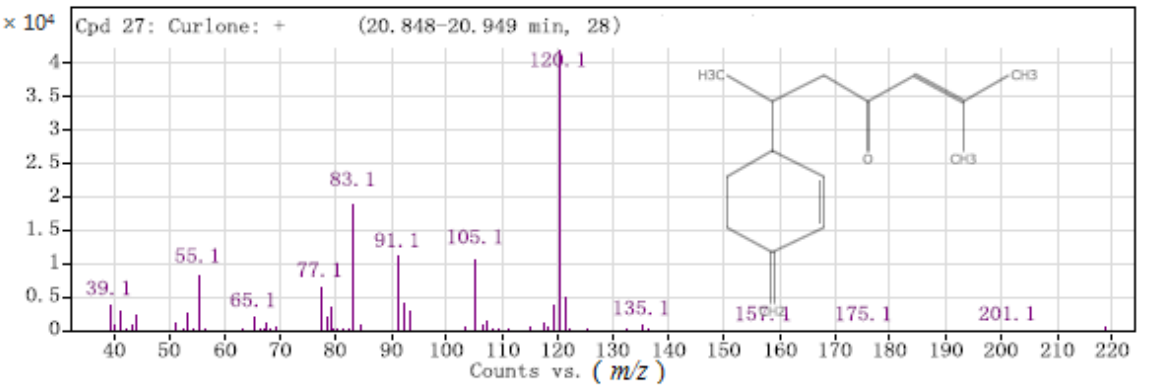
Figure 6. Mass spectrum of curlone.